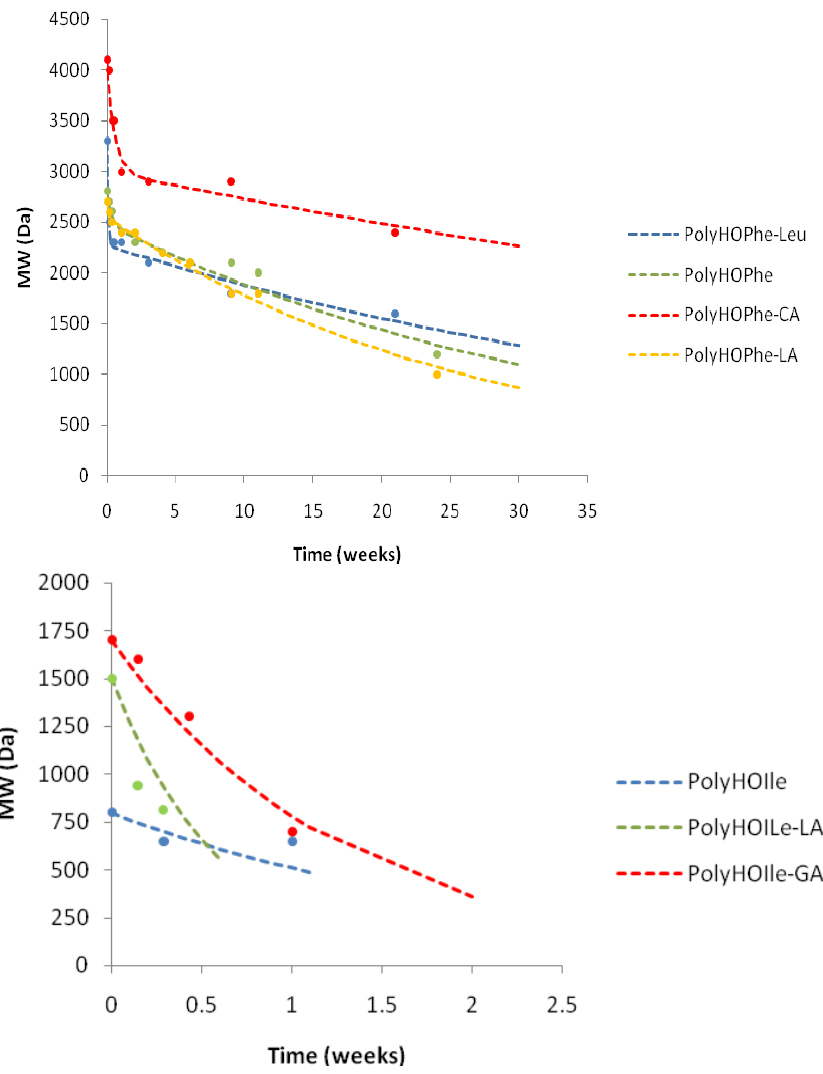
Figure 7. Kinetic pattern of molecular weight decrease during